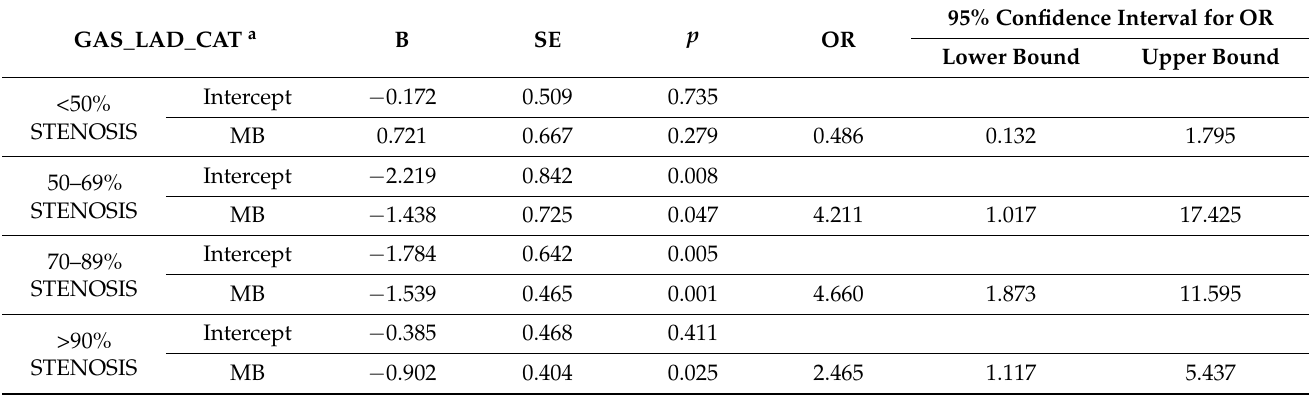
Table 4. Regression model for the probability of atherosclerotic stenosis on the entire left anterior descending artery in the presence of myocardial